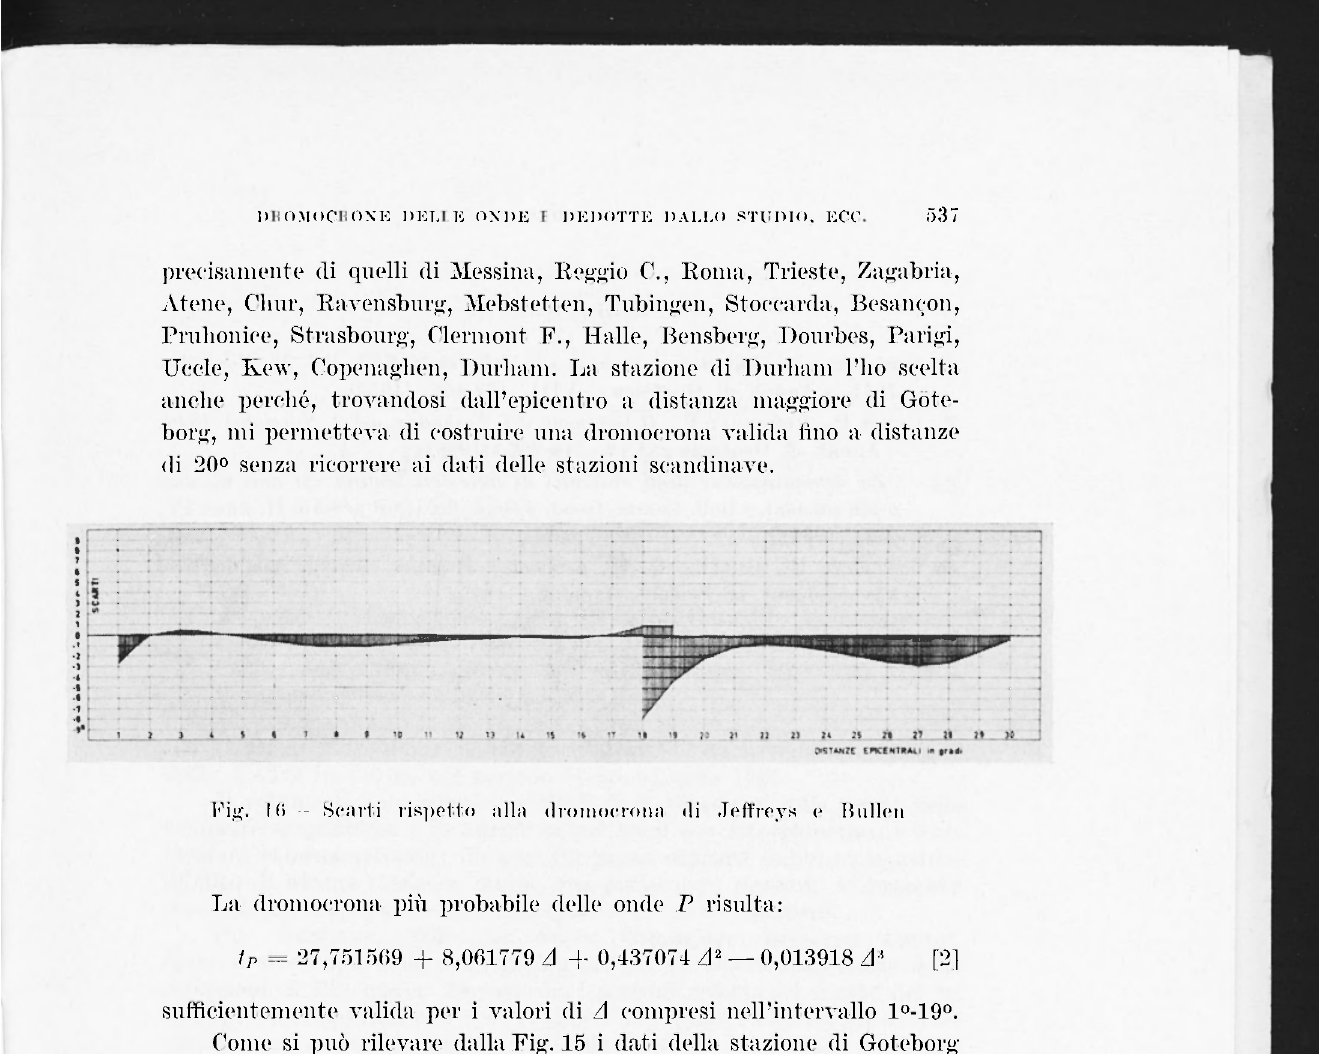
Fig. Hi - Scarti rispetto alla dromocrona di Jeffreys e Bullen